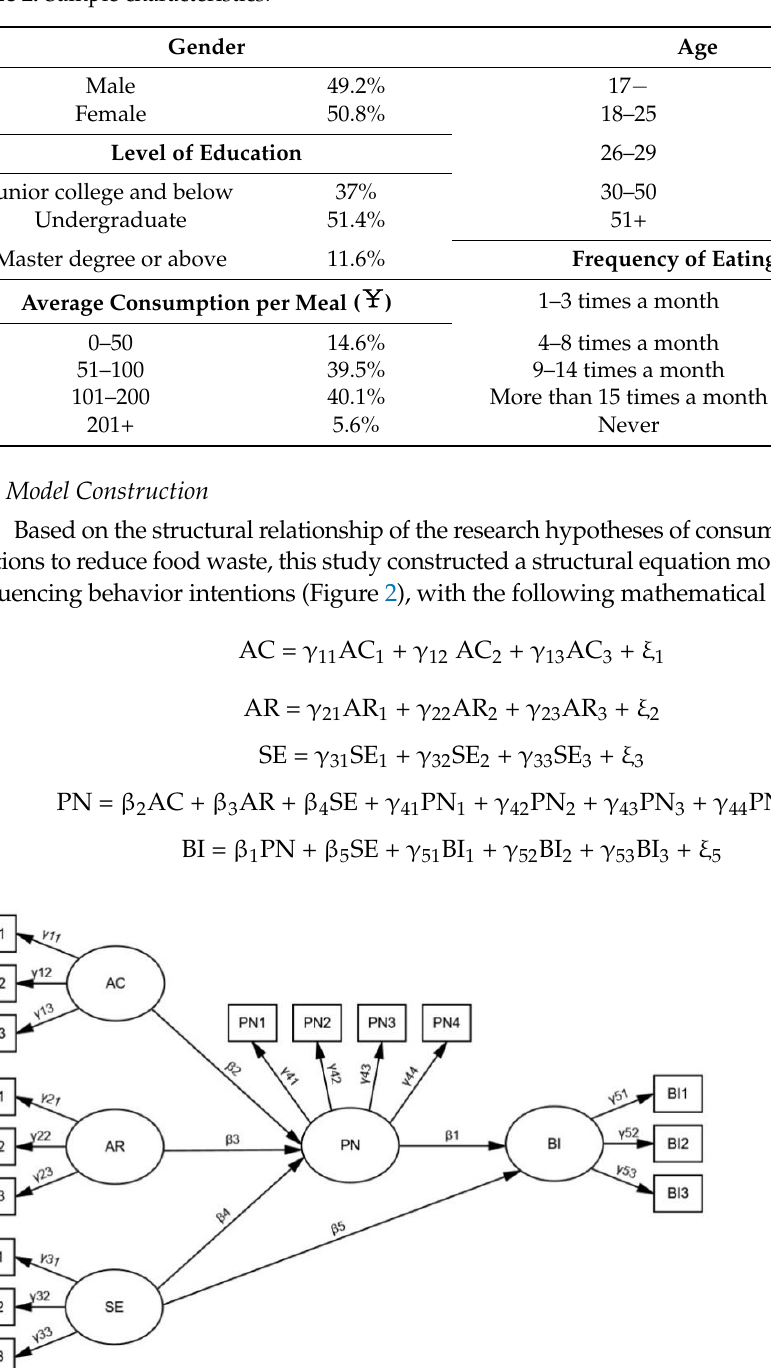
Figure 2. Model. Note: The “ellipse” indicates a latent variable; the “rectangle” indicates an observ- able variable; and the “single arrow” indicates a causal relationship.